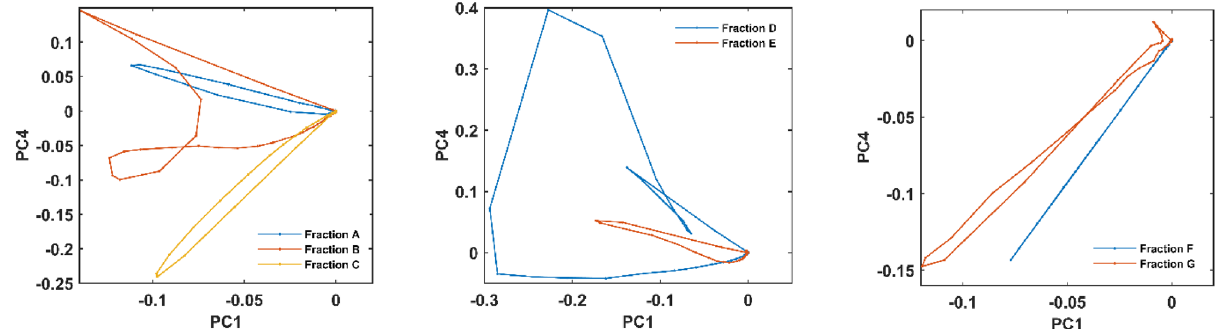
Figure 3. Trajectories for the seven EEM fluorescence images from pooled AEC fraction of CNDs Figure 2a elucidates the trends for the appearance and disappearance of fluorescent components during the dilution process. Corresponding emission and excitation spectra are shown in Fig. 2b,c, respectively. Concentra- tion profiles in Fig. 1 show the fluorophores contribution in the eluted samples and the pooled fractions, while Fig. 2a illustrates their portion in EEM spectral evolution during the dilution process. The number and shape of the resolved excitation and emission profiles for fluorophores in the dilution experiment are different from those for fluorophores in the AEC separation experiment. It means although the existing overall fluorescent groups on all CNDs in the system are the same for both experiments, the linear combinations of the signals (fluorophores) from fluorescent groups observed in the two experiments with distinct conditions are different. The initial rise in the total emission intensity of the solution is resolved into green and yellow profiles (Fig. 2a). Through the first step of dilution (mixture 1 to mixture 2), the fluorescence intensity of the solution enhances, that is due to the reduction of self-absorption and inner filter effect. Decrease and diminishment of the two profiles through the dilution steps confirm that they are made up of aggregation and are from energy acceptor CNDs. The trigger energy (excitation profile) for the yellow component (Fig. 2c) consists of a wide range of wavelengths from 200 to 600 nm, which is proper for receiving energy from many higher energy states. Increasing for the red and blue profiles is observed as well as green and yellow in the first 2 dilution steps (Fig. 2a). For the next three dilution steps (3, 4, and 5) the red and the blue profiles, that are related to energy donor particles, grow sharply. This is due to the dissociation of aggregated particles and reduction of energy transfer during dilution. This rising is along with the decreasing of yellow and green profiles (that correspond to energy acceptor particles) and demonstrates the getting apart of CNDs. By progressing the dilution to steps 6 and 7, the rising violet profile (that is from energy donor CNDs) with higher emission energy (310 nm), leads to a decrease in the intensity of other profiles. The next level for dissociation of aggregated CNDs happens in steps 8 and 9 in which, the green and yellow profiles tend to zero and the others ascend sharply. In steps 10 to 13 of dilution, the dilution results in a decreasing trend for the red and blue profiles but an obvious uprise in the violet profile. The violet profile consists of some luminescence states including 310 nm, 440 nm, and the broad- band at 500–600 nm, which mainly forms the EEM pattern in the last diluted solution (Figure S4). The CNDs that are related to the red and the blue profiles are energy donors to the particles that correspond to yellow and green profiles. Additionally, they are energy acceptors from particles that are related to the violet profile. It was concluded from the observed rise and fall off of the red and the blue profiles along with the experiment steps. During the dilution experiment, the overall emission intensities of CND mixtures (grey dashed line) remained almost steady although the emission wavelengths are changed. This is another piece of evidence that confirms the presence of energy transfers between particles.